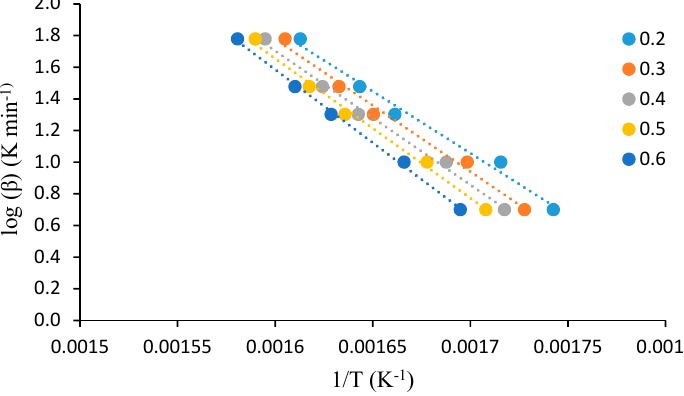
Figure 1. A plot of log β vs. 1/ T at various α values (given as the inset) for β -cyclodextrin.